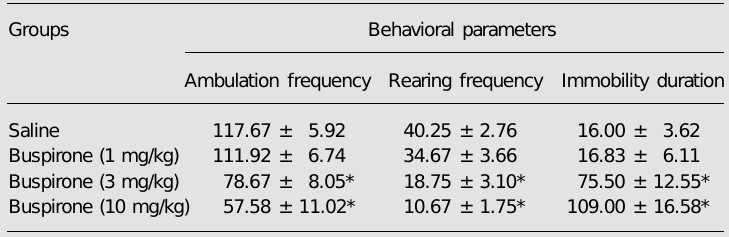
Table 1. Effect of acute administration of different doses of buspirone on open-field behavior. Groups